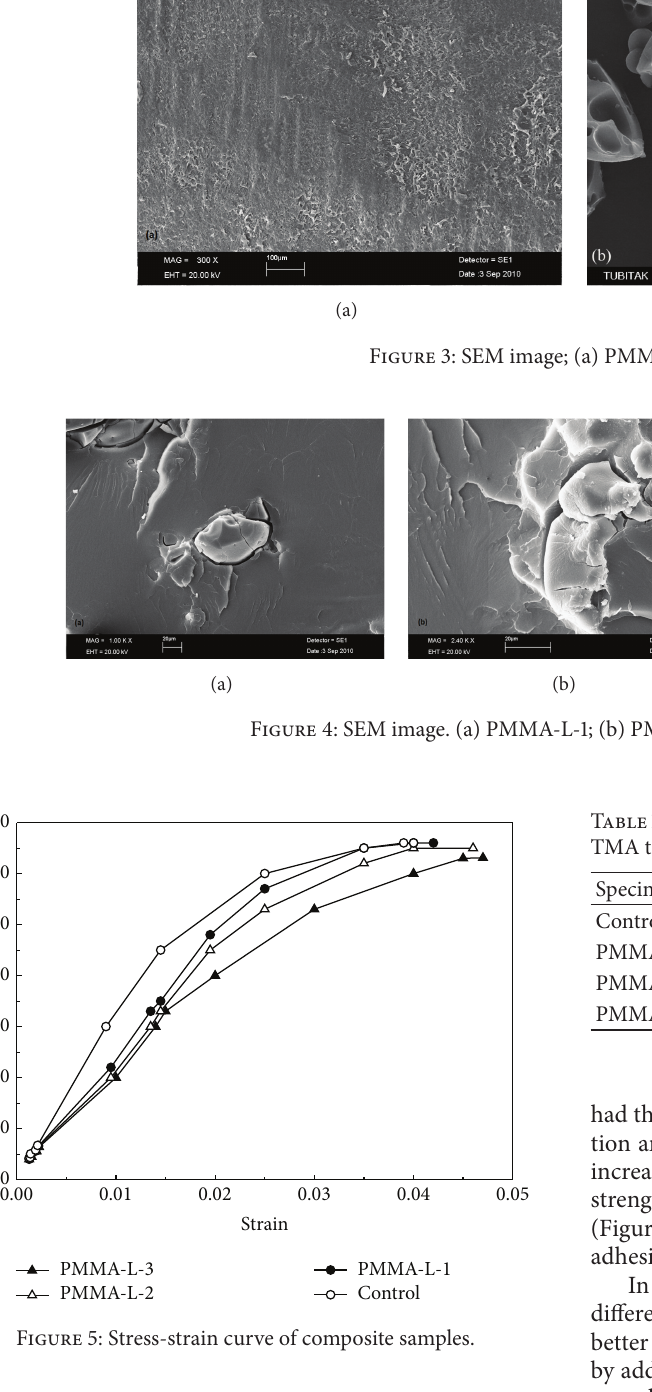
found that PMMA (control) sample group had the highest transverse strength ( 80.24 ± 8.69 MPa).